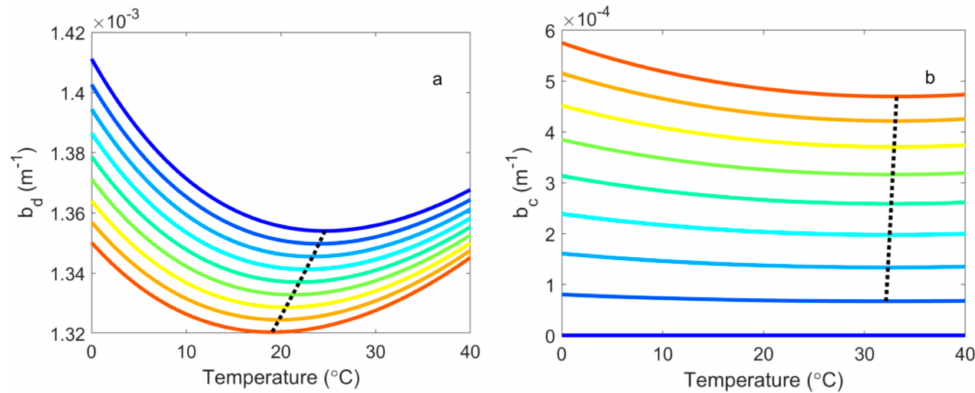
Figure 2. Light scattering by pure seawater at 546 nm as a function of temperature and salinity. ( a ) b d , the scattering due to density fluctuation; and ( b ) b c , the scattering due to concentration fluctuation. Lines of progressive colors from blue to red correspond to different salinities from 0 to 40 psu, at 5 psu increments. The dotted line in each plot connects T min at different salinities.